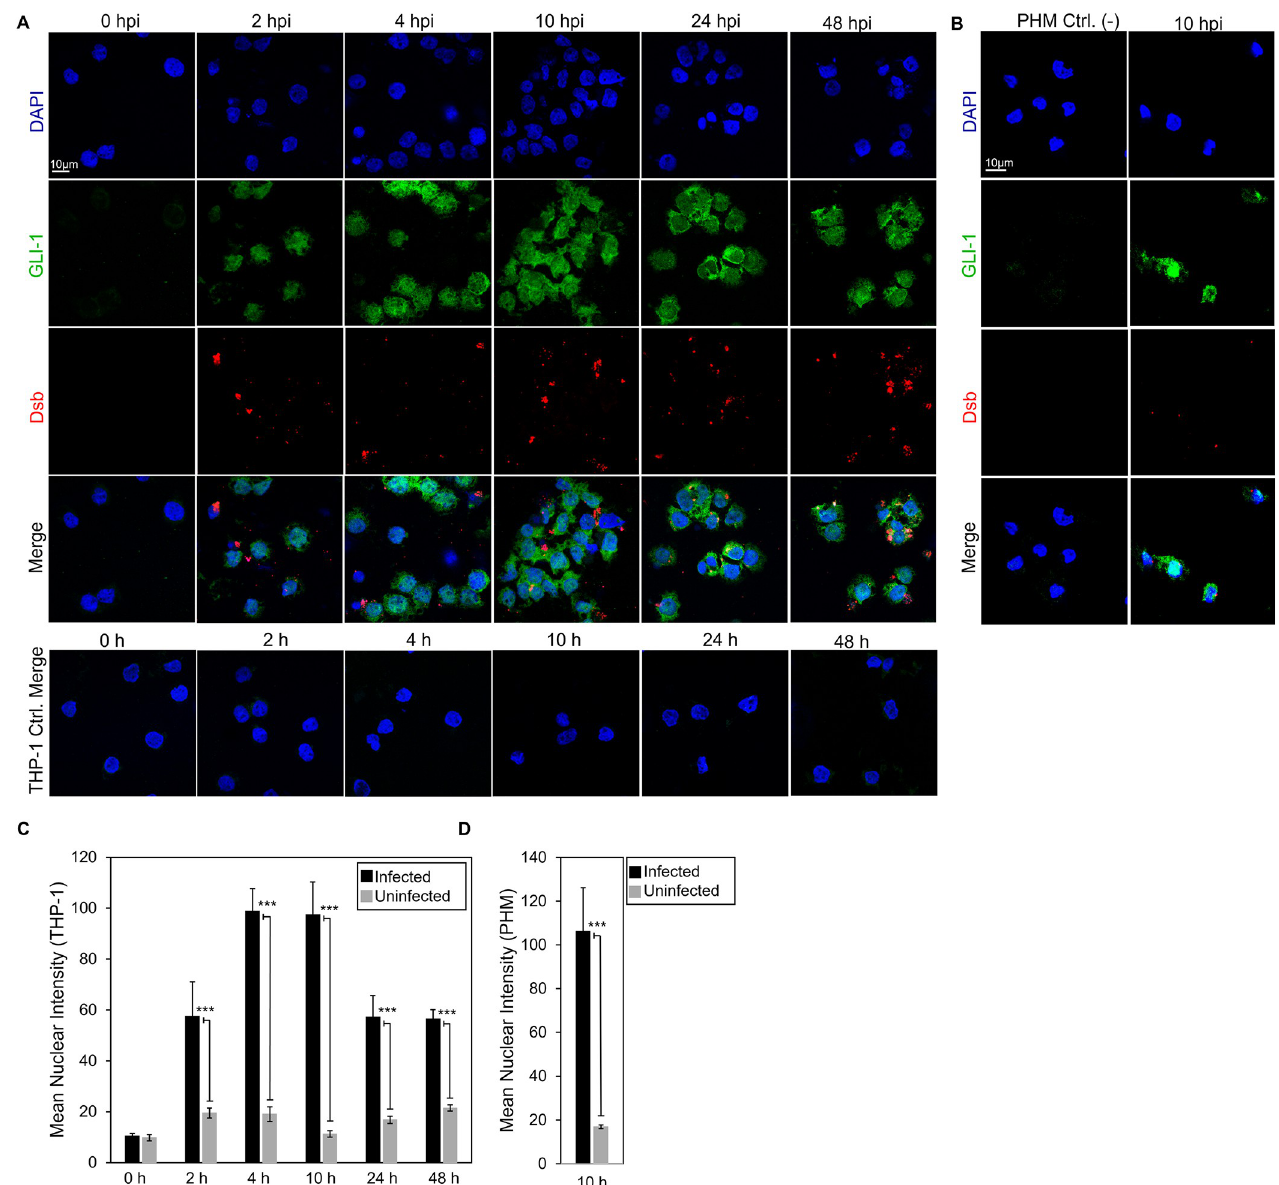
Fig 4. E . chaffeensis activates the Hh signaling pathway in THP-1 cells and primary human monocytes. (A) Confocal microscopy of uninfected and E . chaffeensis infected THP-1 cells stained with anti-GLI-1 antibody at 2, 4, 10, 24 and 48 hpi, showing a temporal increase in GLI-1 compared to the uninfected controls. Uninfected and E . chaffeensis infected (MOI 100) THP-1 cells were stained with anti-Dsb antibody (red) at 2, 4, 10, 24 and 48 hpi demonstrating infection of THP-1 cells with E . chaffeensis (scale bar = 10 μ m). (B) Confocal microscopy of uninfected and E . chaffeensis- infected primary human monocytes at 10 hpi showing upregulation of GLI-1 (green). Uninfected and E . chaffeensis- infected primary human monocytes were stained with anti-Dsb antibody (red) to confirm E . chaffeensis infection (scale bar = 10 μ m). (A-B) Experiments were performed with at least three biological and technical replicates. Randomized areas/slide (n = 10) were used to detect GLI-1 nuclear translocation. (C-D) Intensity graphs demonstrate the mean nuclear accumulation of GLI-1 in respective THP-1 cells and primary human monocytes. Analysis was performed using ImageJ and determining mean grey value from randomized areas/slide (n = 10). selected genes in the Hh PCR array between infected and uninfected cells at 48 hpi is shown in Fig 5B . We also confirmed immunofluorescent microscopy results by probing nuclear frac- tions of uninfected and E . chaffeensis- infected THP-1 cells with GLI-1 specific antibody by immunoblot. Progressive nuclear accumulation of GLI-1 was observed over 48 hpi